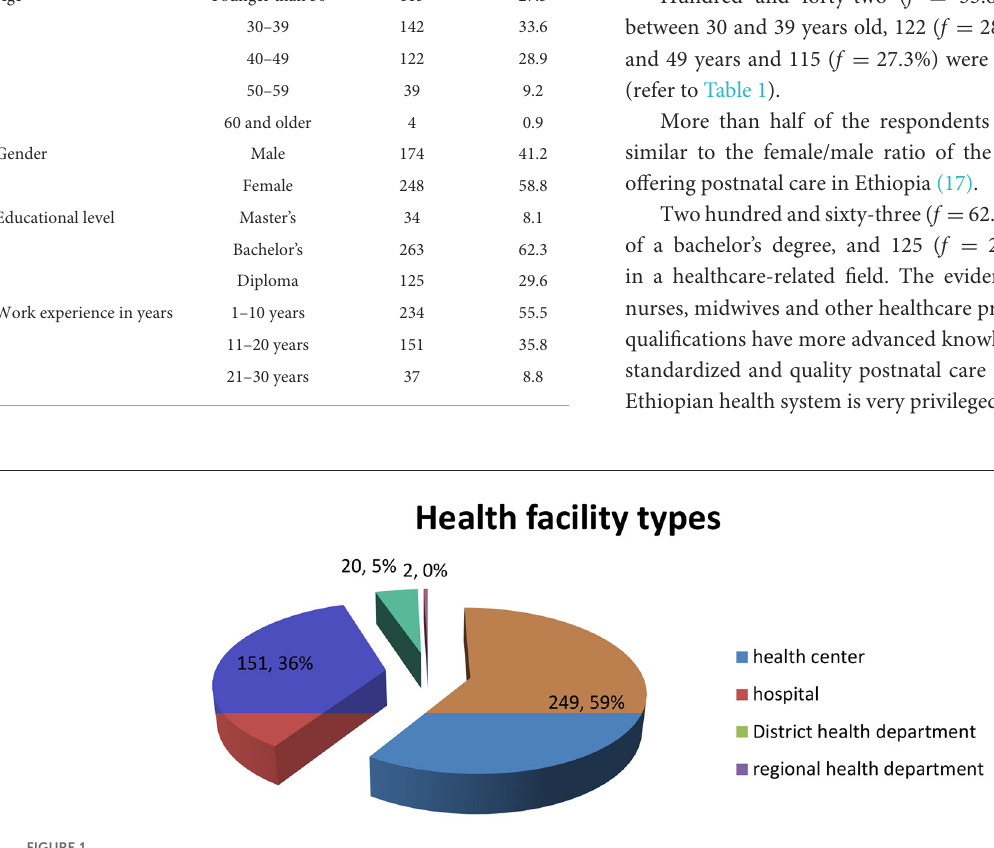
FIGURE1 Distribution of respondents per type of health